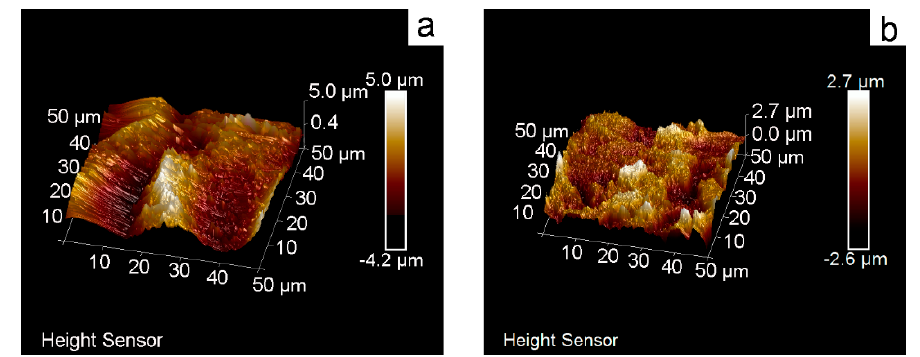
Figure 6. AFM images of the treated samples: ( a ) AO, ( b ) 0.02 mol/L CA.